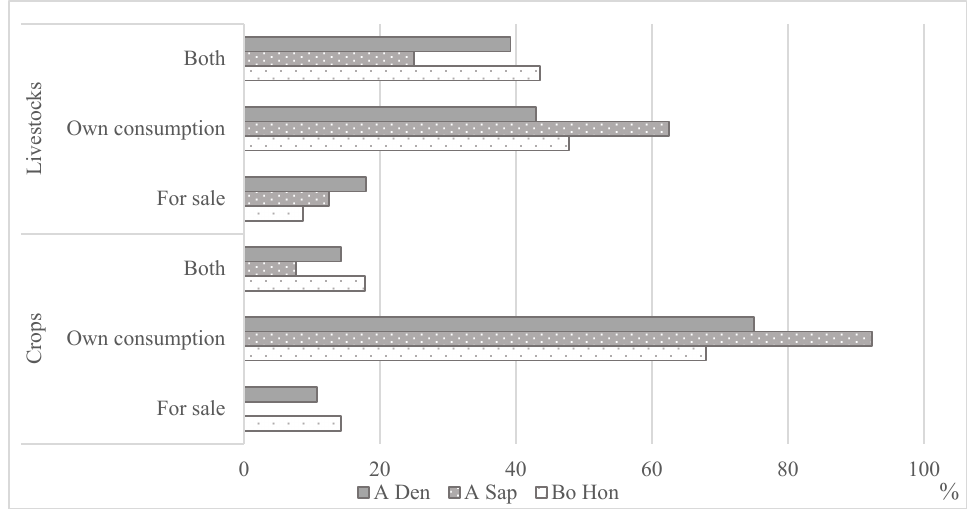
Figure 6. The purposes of crop produce and livestock by villages.